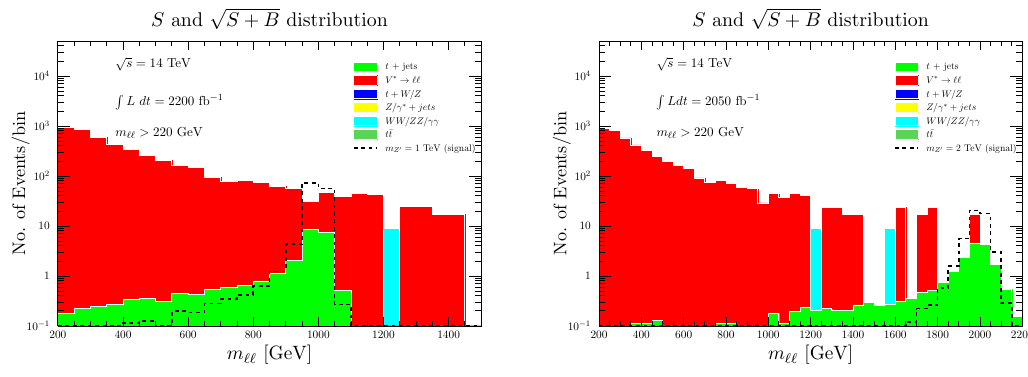
Figure 9 . The dilepton invariant mass distribution for the signal and background samples. The analysis is for the case of two benchmarks discussed in the text, i.e., for ( m Z 0 , δ ) cases (1 TeV, 10 − 2 ) and (2 TeV, 3 × 10 − 2 ) using the cut-and-count method with cuts on the variables of eq. (5.1). This method is found not efficient for discovery with a projected luminosity of 3000 fb − 1 at HL-LHC. A better technique is discussed in the next